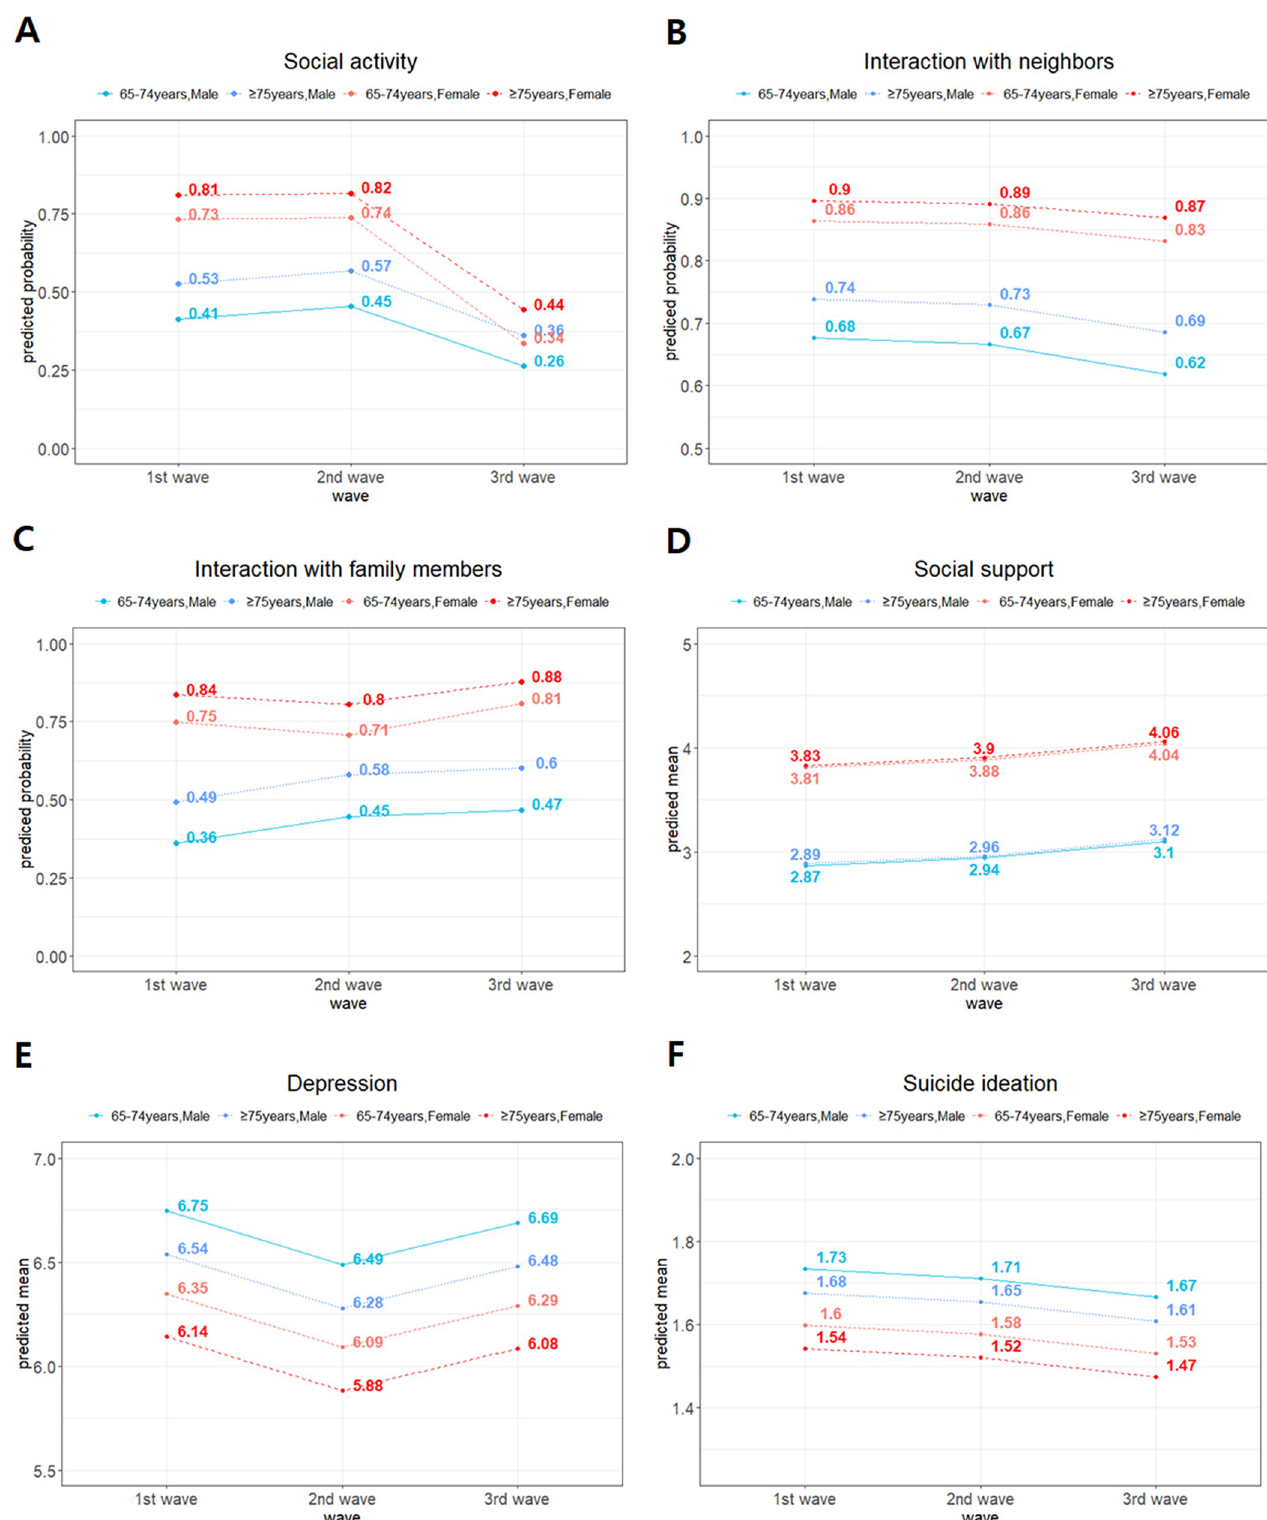
Fig 3. Changes in social relationships and mental health while considering the interaction effect. The (A) social activity and (C) interaction with family members showed significant interaction effects based on sex across the waves.